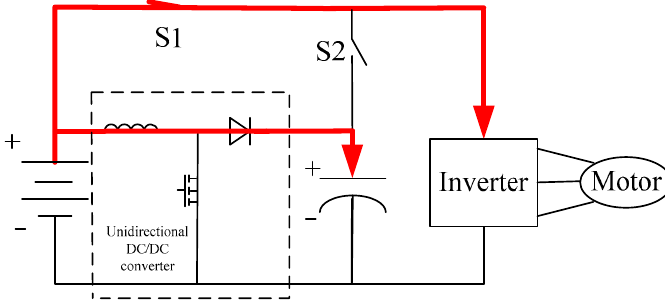
Figure 7. Mode 4—the battery supplies power to the motor load and SC simultaneously.